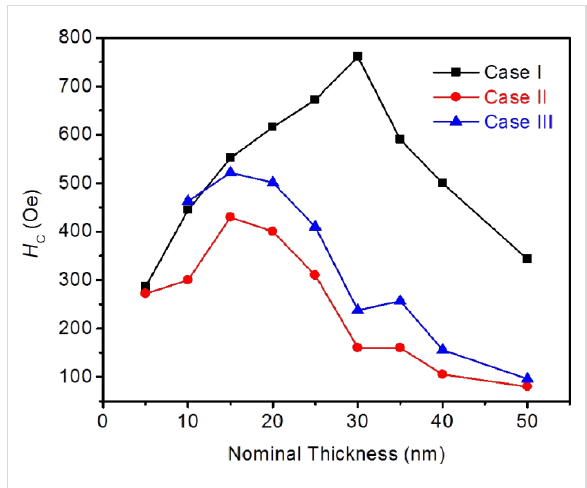
Figure 6: Coercive field ( H C ) obtained from the simulations of iron nanowires with nominal width of 250 nm and varying nominal thick- ness (from 5 to 50 nm) for the three cases discussed in the